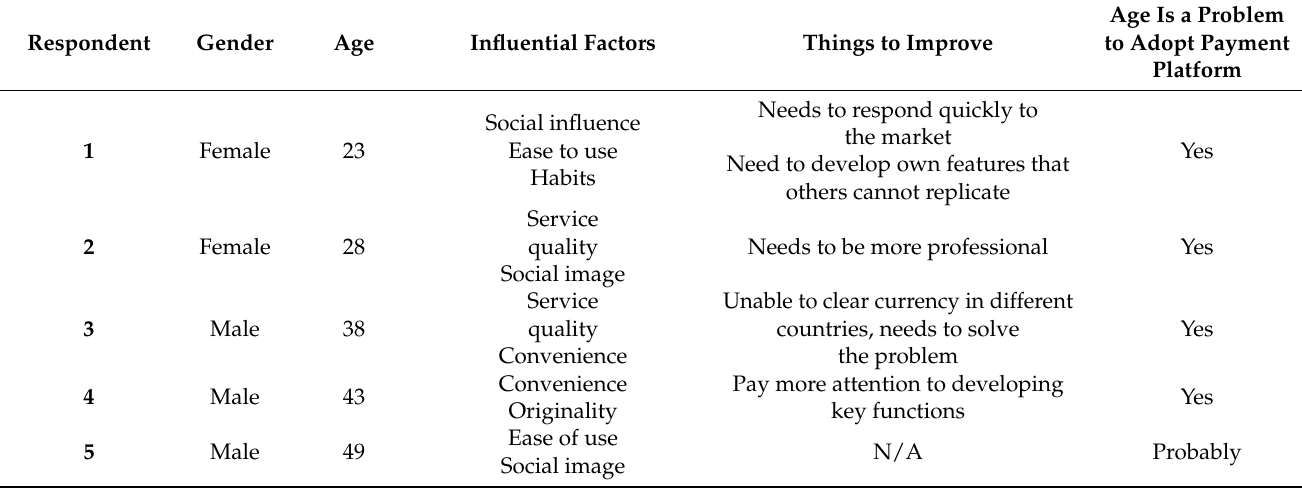
Table 3. Summary of the individual interviewees.